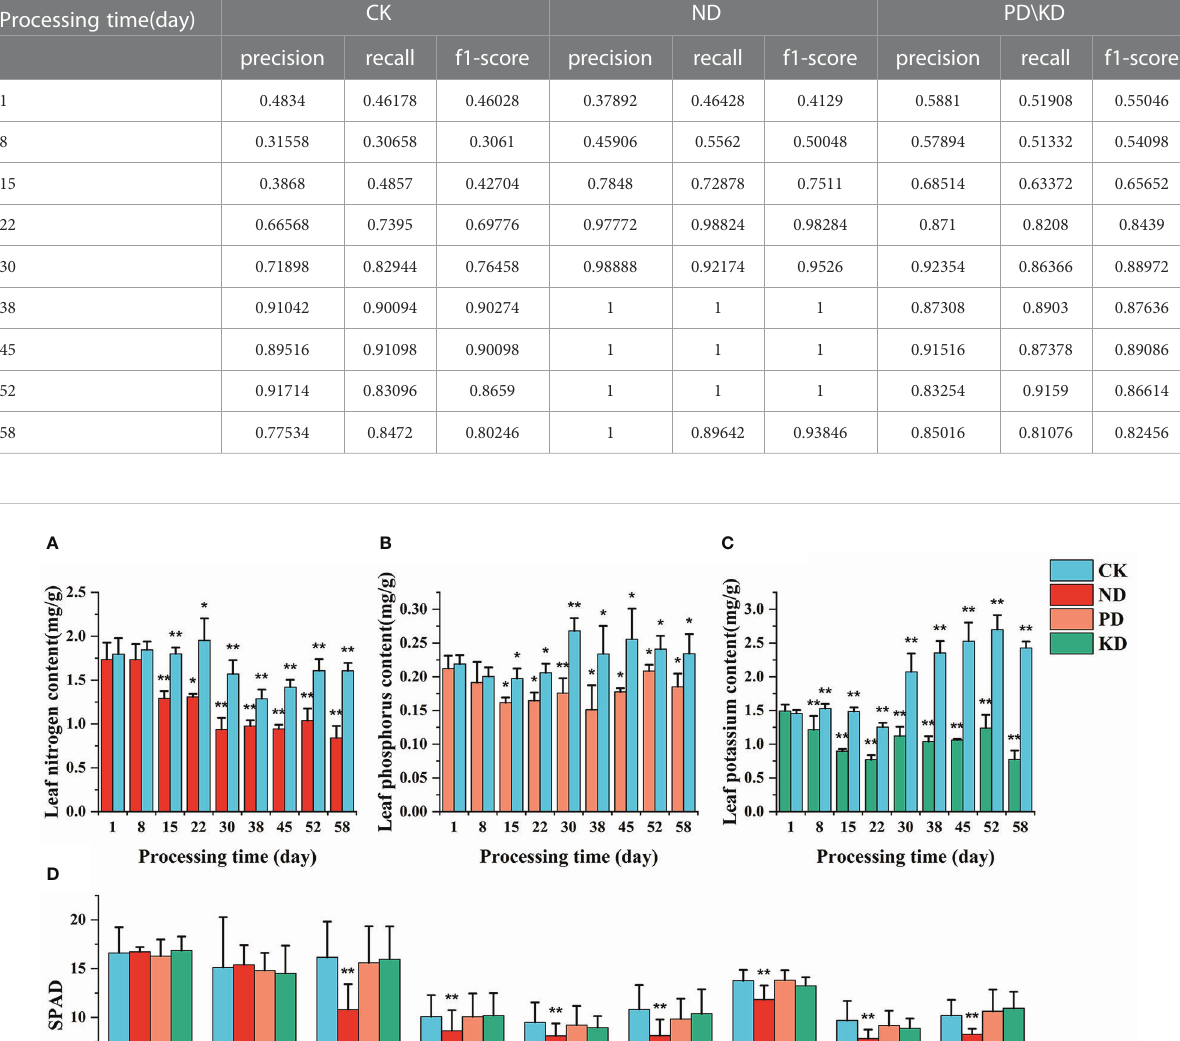
TABLE 3 Evaluation index of models in different stress stages.